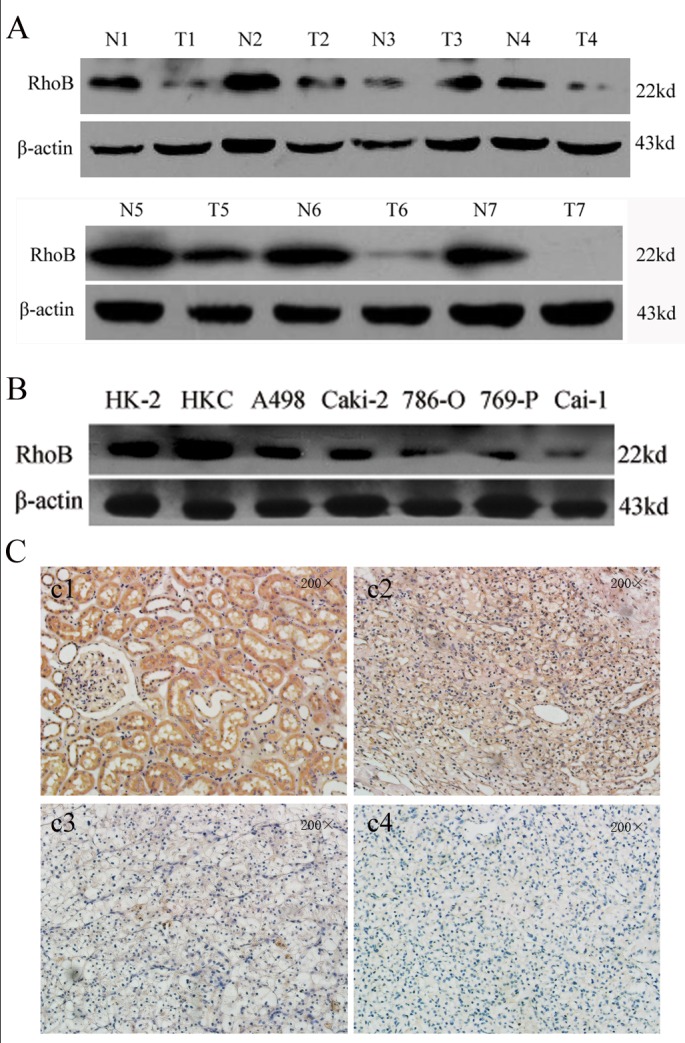
RhoB expression is downregulated in ccRCC tissues and cell lines.(A) RhoB protein expression was detected in surgical specimens of ccRCC and their corresponding adjacent non-tumorous tissues by western blot analysis. (B) Expression of RhoB in the ccRCC-derived cell lines A498, Caki-2,786-O, 769-P, Caki-1 and human renal proximal tubular cell lines (HKC and HK2) was detecte by western blot. β-action was used as an internal control. (C) RhoB protein expression in ccRCC tissues and the matched noncancerous counterpart of the T1 stage ccRCC tissues. (200×c1, 200×c2, the T1 stage of ccRCC tissues and its corresponding noncancerous tissues; 200×c3,the T2 stage of ccRCC tissues; 200×c4, the T3 stage of ccRCC tissues).